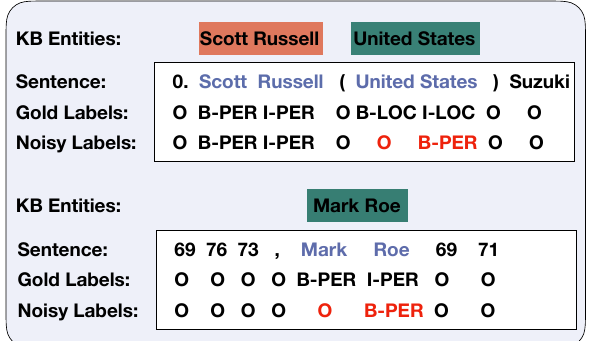
Figure 1. Two types of noisy labels exist in the current distant NER datasets (CoNLL03). (1) Category error: the exact label (a none type entity and a PERSON type entity) for the mention United States is wrong. (2) Span error: the mention Mark Roe is wrongly linked to Roe instead of